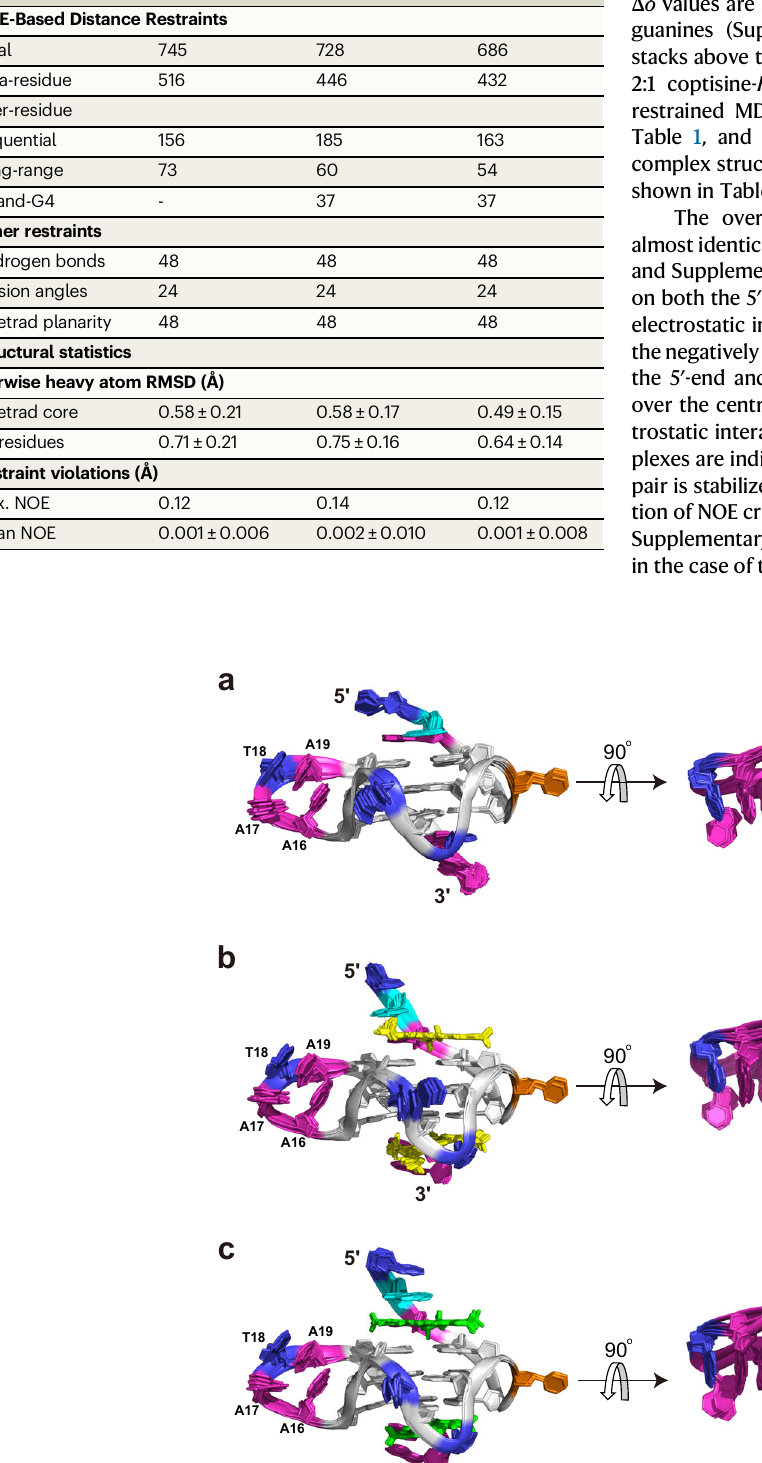
structure calculations. Yellow, berberine; green, coptisine; cyan, fl anking guanine; gray, tetrad guanine; magenta, adenine; blue, thymine; orange, cytosine.